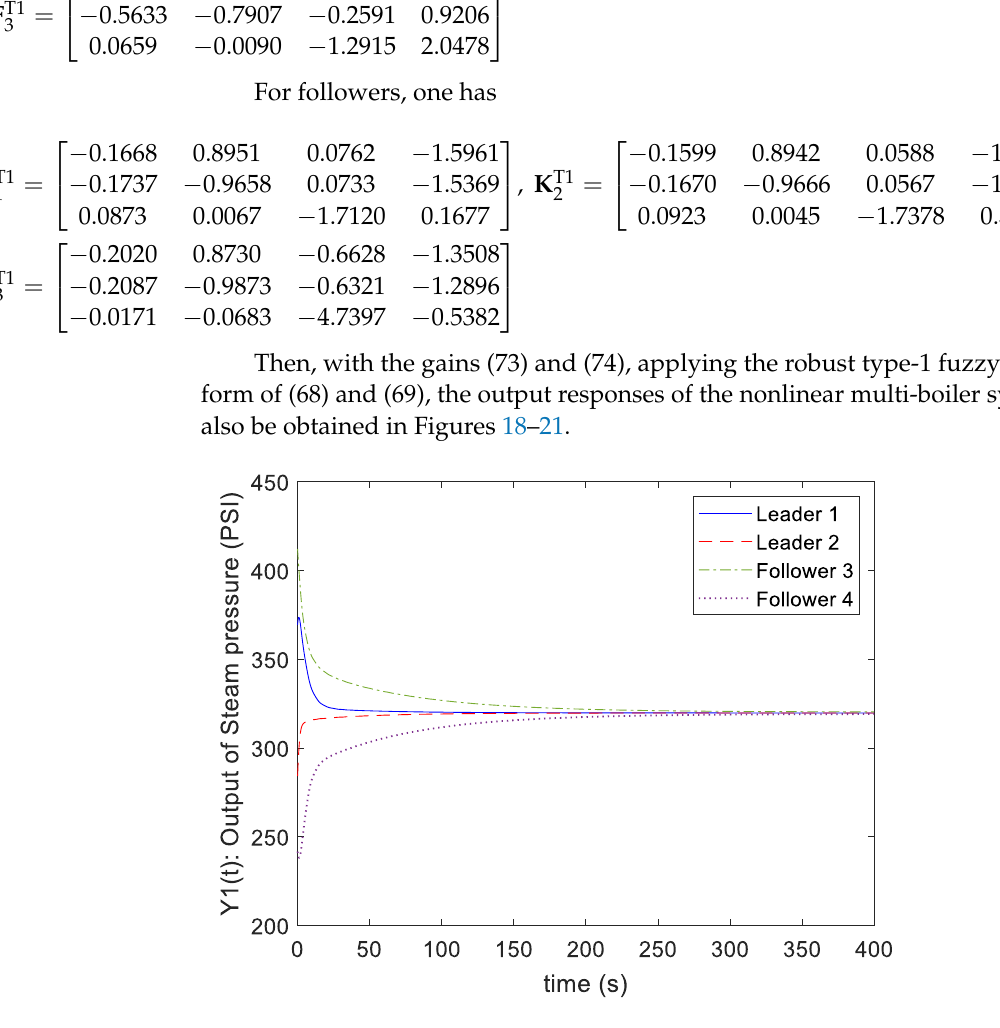
Figure 19. Responses of output   2 Y t with type-1 robust fuzzy control.